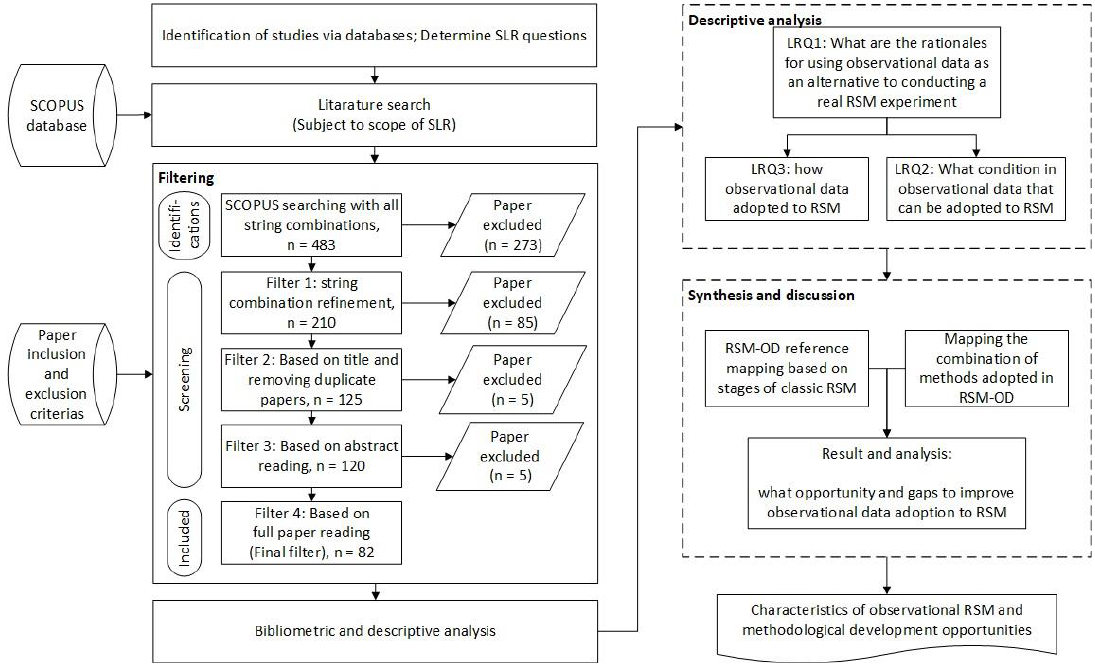
Figure 3. Systematic literature review framework based on PRISMA [18].